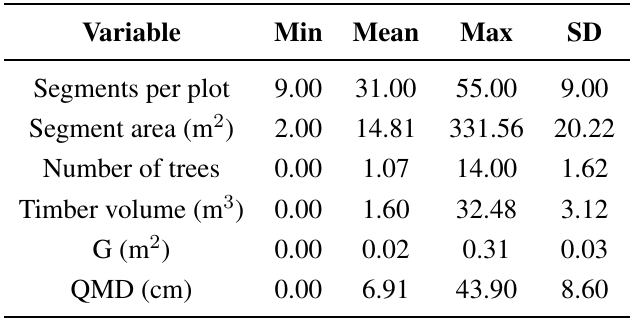
Table 4. Statistics of segments and assigned field